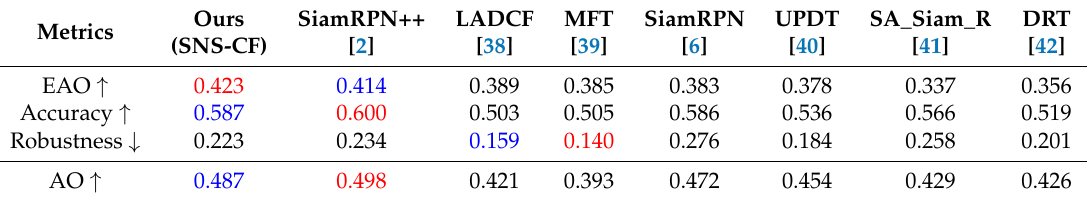
Table 2. Comparison with the state-of-the-art trackers in terms of Expected Average Overlap (EAO), Robustness and Accuracy on the VOT-2018 [9]. Red and blue numbers indicate the best and second best results,